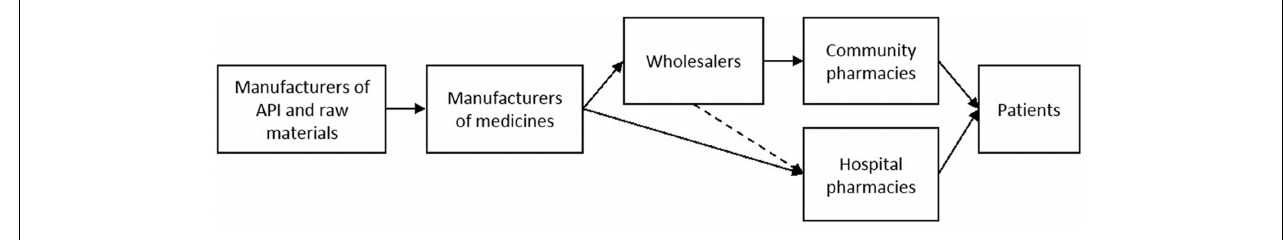
FIGURE 1 | Supply chain of manufacturing and delivering human medicinal products. API = Active Pharmaceutical Ingredient; - - - - - = only a small part of the total products ordered by hospital pharmacies are ordered via wholesalers.